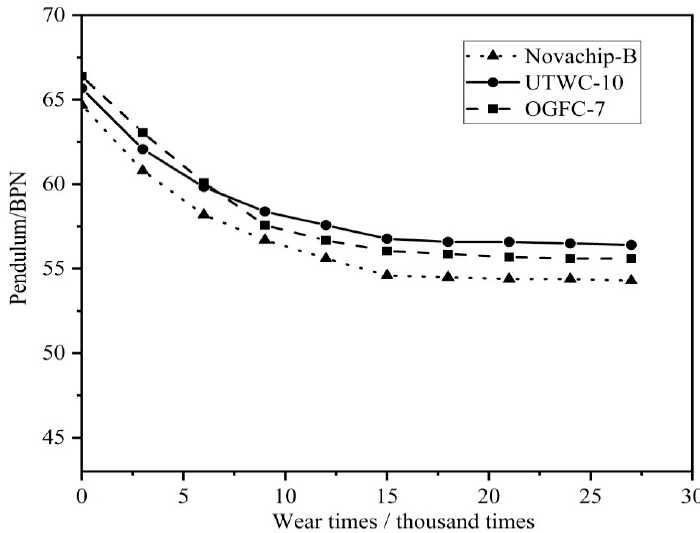
Figure 10. The anti-sliding performance attenuation curves of the three asphalt mixtures.